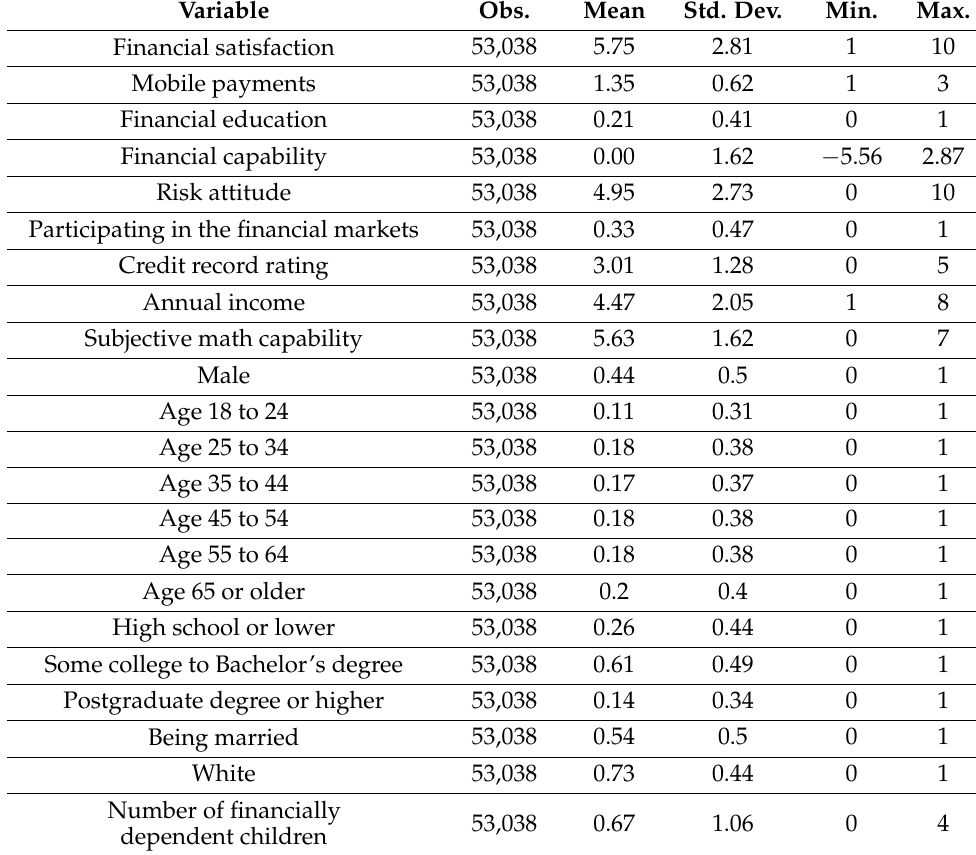
Table 2. Descriptive